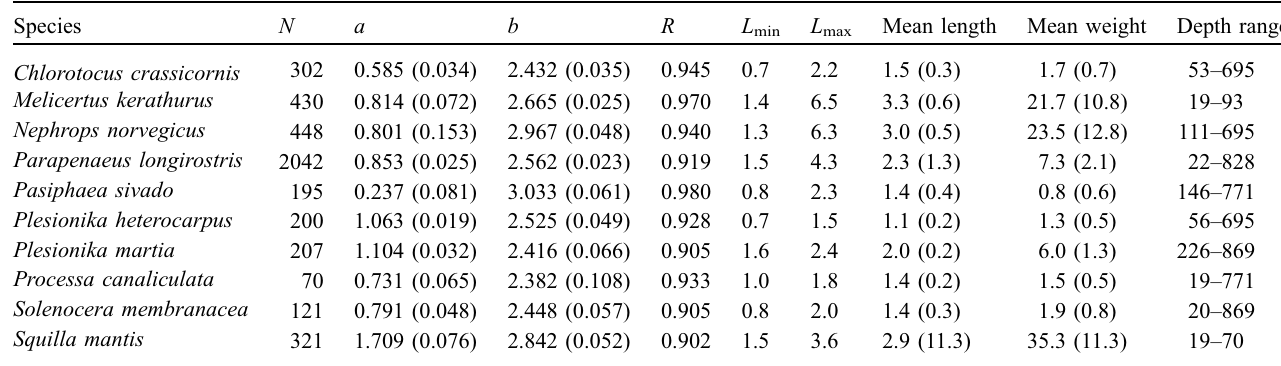
Table 1. Parameter estimates of the length – weight relationship for the selected crustacean species in the Gulf of Cadiz: N (sample size), a intercept (CV by bootstrap), b slope (CV by bootstrap) and R coef fi cient of determination. Lengths are presented for cephalothorax (cm): L min minimum observed length, L max maximum observed length and mean length (SD), and weights are mean wet weights in g (SD). Depth range (m) is also shown for each species in the study area.